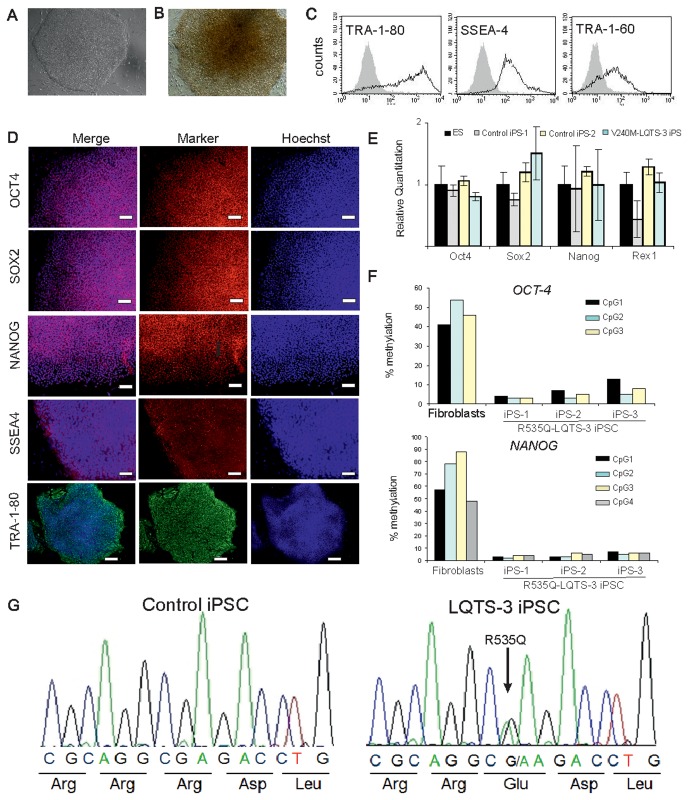
Characterization of LQTS-3 iPS cells.V240M-LQTS-3 iPS cell colony derived from patient NP0016 showing typical human ES cell-like morphology (A) and positive staining for alkaline phosphatase (B). The V240M-LQTS-3 iPS cell colonies expressed pluripotency markers OCT4, SOX2, NANOG, SSEA4, TRA-1-80 and TRA-1-60 as determined by flow cytometry (C) and immmunostaining (D). Expression of pluripotency markers in V240M-LQTS-3 iPS cells by qRT-PCR. Expression values were normalized to GAPDH and are presented as mean +SEM (n=3) relative to corresponding transcript levels in human ES cells (E). Methylation levels of promoter regions of OCT4 and NANOG genes in three different clones of R535Q-LQTS-3 iPS cells at passage 7 and R535Q-LQTS-3 fibroblasts (F). The LQTS-3 iPS colonies derived from dermal fibroblasts of patient NP0012 were verified for the presence of a heterozygous SCN5A point mutation p.R535Q by DNA sequencing (G).